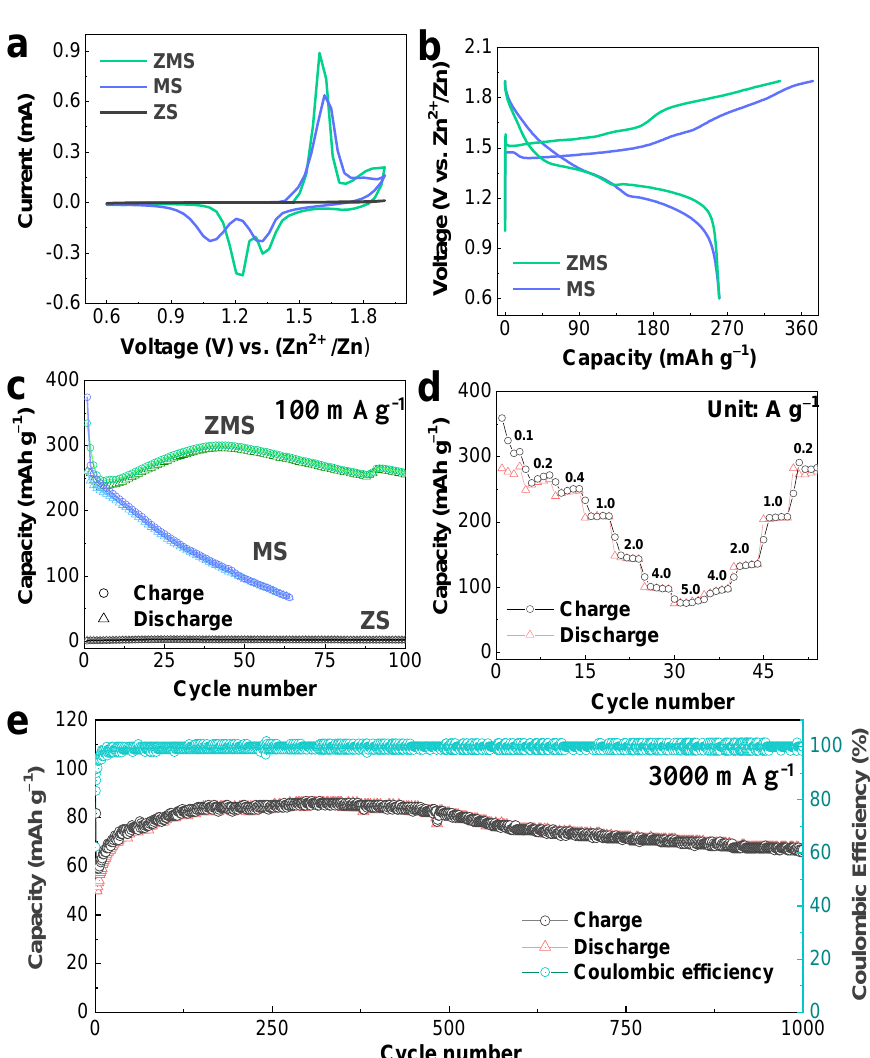
Figure 2. ( a ) CV curve of ZnO microspheres at 0.1 mV s − 1 rate in ZS, MS, and ZMS electrolytes, ( b ) charge/discharge patterns of ZnO microspheres at 100 mA g − 1 in MS and ZMS electrolytes for the first cycle, and ( c ) the corresponding cyclability profiles of the different electrolytes. ( d ) The rate capability profile of ZnO microspheres at various current rates in the ZMS electrolyte and ( e ) cyclability profile of ZnO microspheres at a current density of 3000 mA g −1 in the ZMS electrolyte.